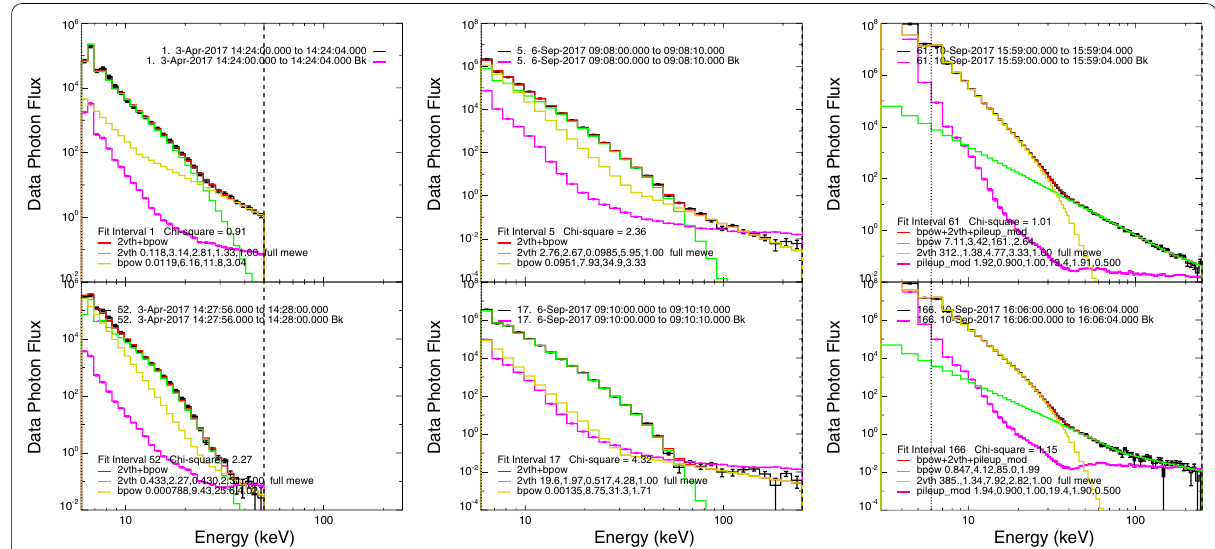
Fig. 7 Photon flux (in photons/s/cm 2 ) of the flares considered in Fig. 6, for two times: the peak of the HXR (top) and the peak of SXR (bottom). The final black spectrum results from the composition of several fits for the thermal part and non-thermal parts. The model of each fit is described on the bottom left together with the colour code (red, green and yellow). The purple curve indicates the background level. The time interval to build the photon flux is indicated on the upper part of each panel. The vertical dashed line on the left panel indicates the energy limit of the